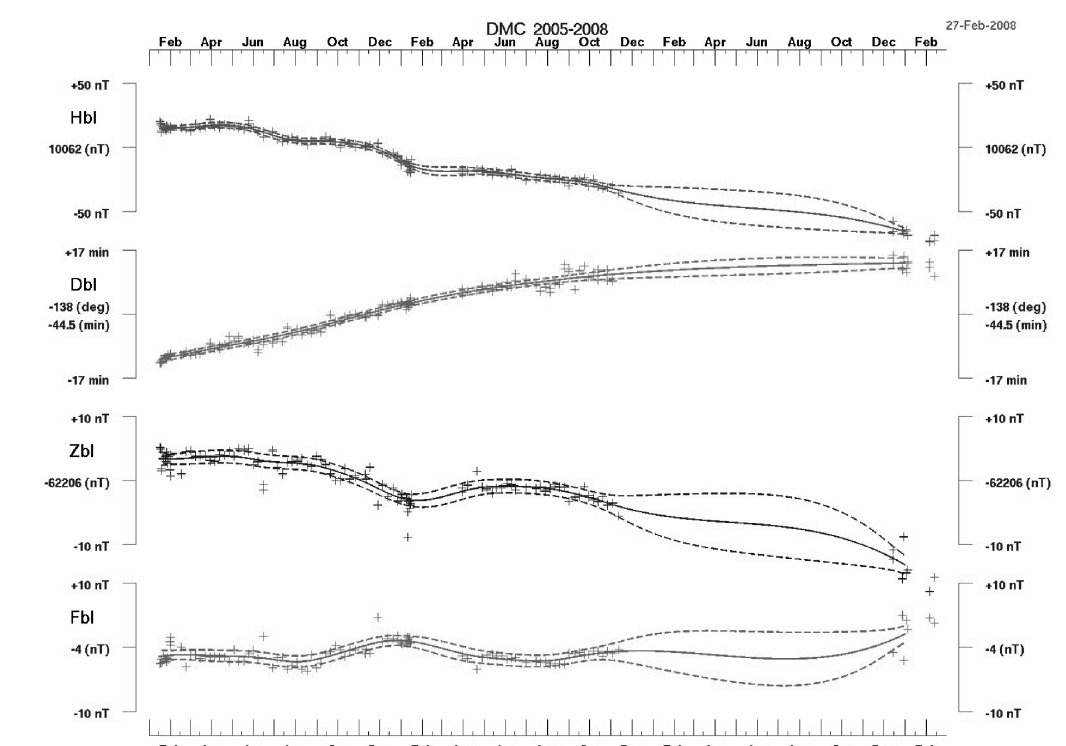
Fig. 2. 2005-2007 base line fitting using cubic splines for the horizontal H component, declination D, vertical component Z, total field difference F between the proton magnetometer measurements on the absolute pillar and variometer measurements on the absolute pillar and variometer cave respectively. Crosses: spot values; solid lines: spline adjustment; dashed lines: limits of the 95% confidence